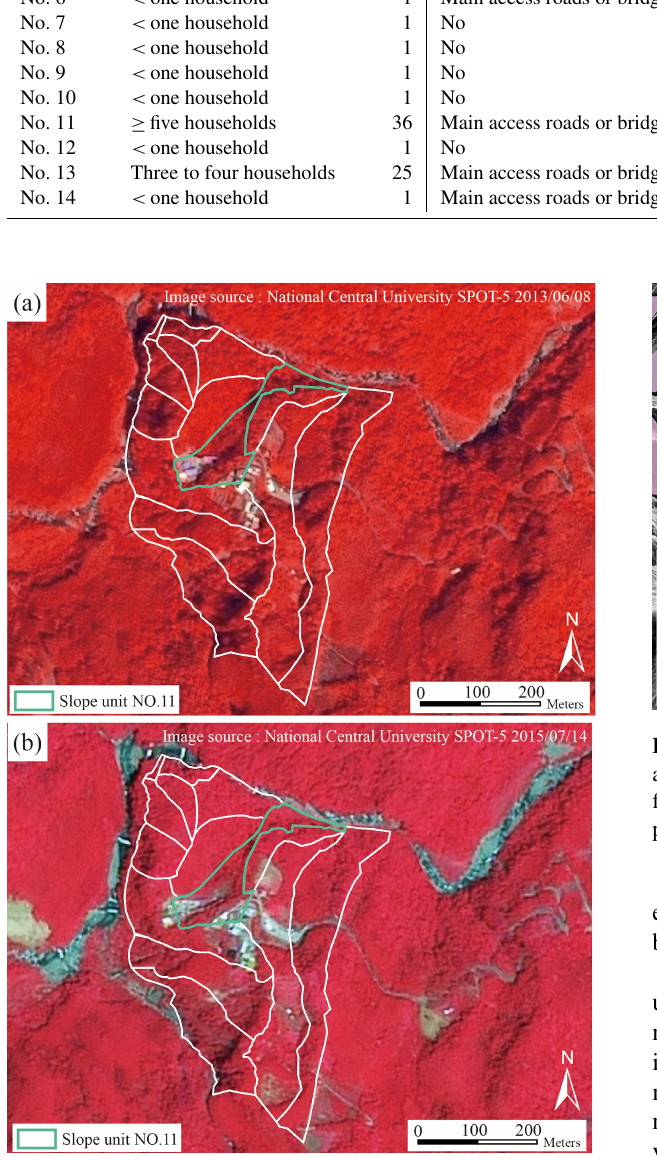
Figure 8. Comparison of the terrain features in (a) 2013 and (b) 2015 orthophoto maps at the No. 11 slope unit (modified from National Central University SPOT-5 2015; aerial: ESRI Ar- cGIS 10.4).